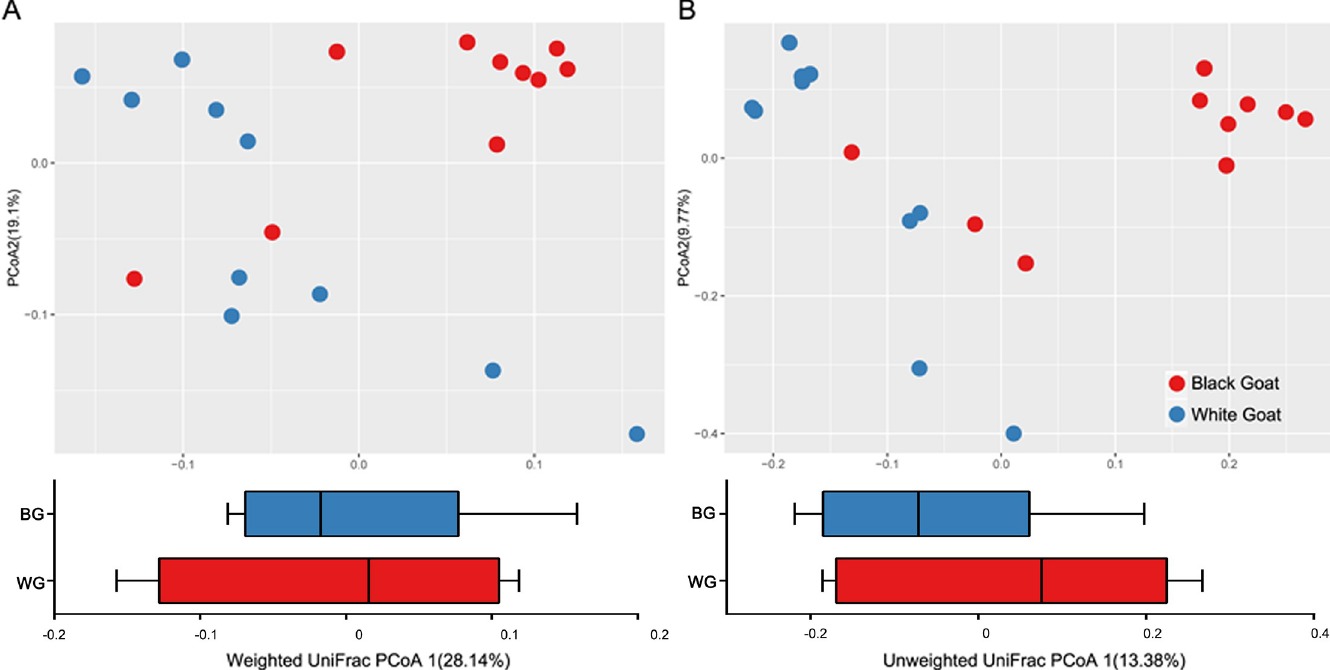
Fig 2. PCoA score plot based on weighted (A) and unweighted (B) UniFrac metrics for all samples. Each point represents the composition of the intestinal microbiota of one sample.